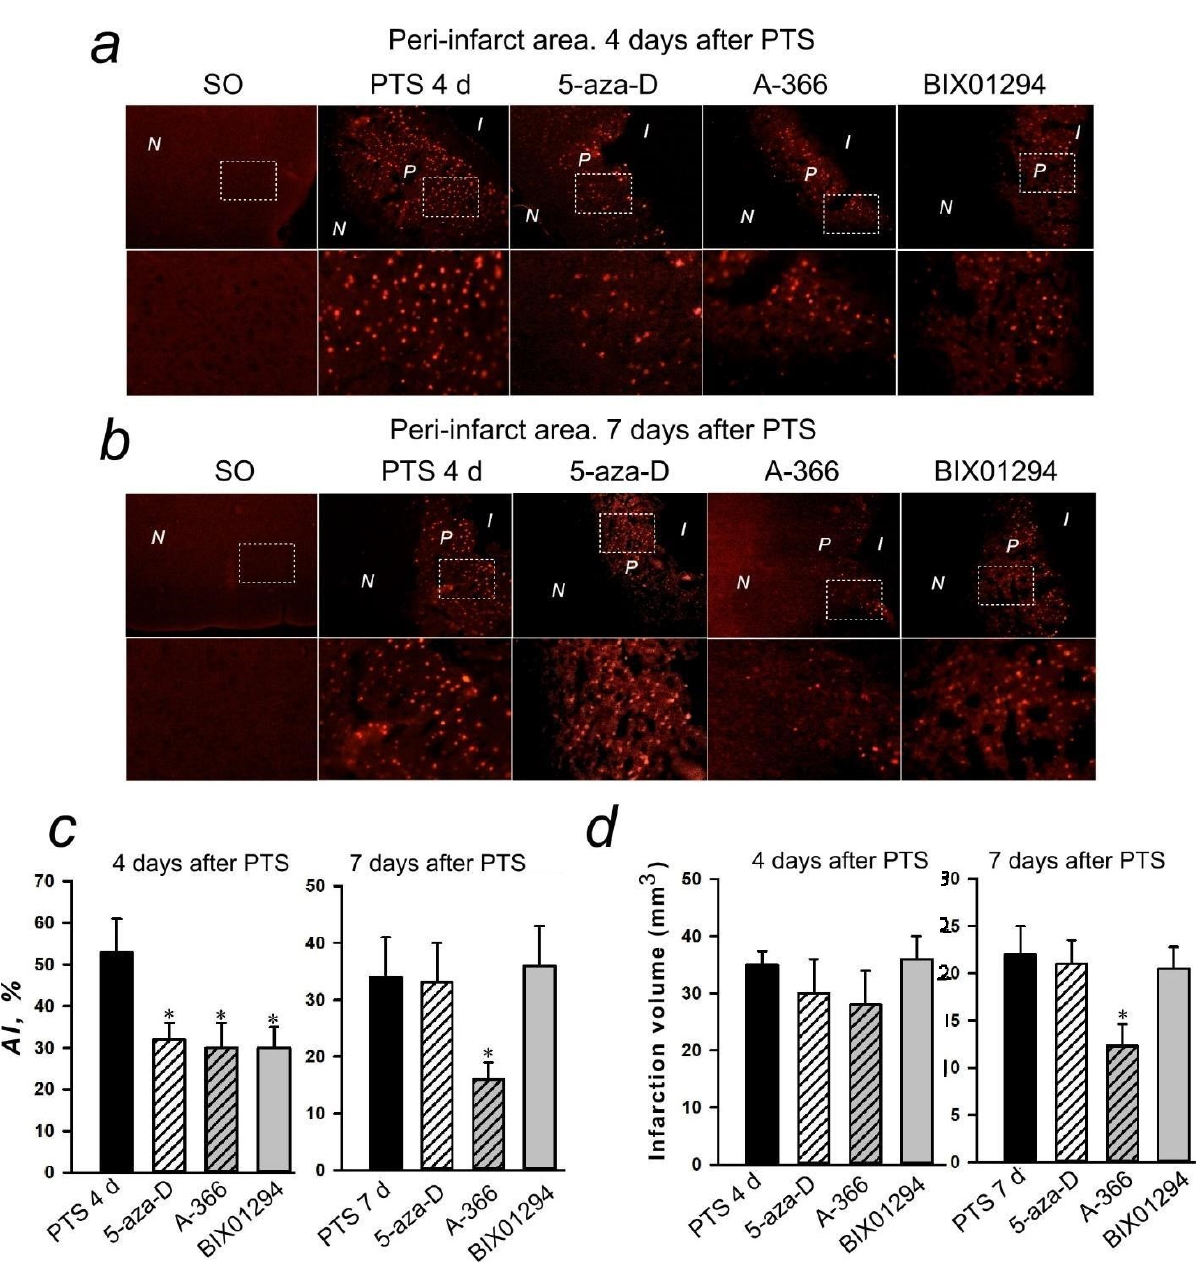
Figure 13. Apoptosis in the peri-infarct (P) area induced by photothrombotic stroke (PTS) in the mouse cerebral cortex. ( a , b ) Typical images of cortical regions stained with TUNEL (red fluorescence of apoptotic cells) at 4 days ( a ) and 7 days ( b ) after PTS. P-peri-infarct area, I-infarct area, N-normal tissue area. Control: sham-operated animals (SO). Experimental groups: The cerebral cortex of mice injected by various inhibitors. Inhibitors: 5-aza-2 ′ -deoxycytidine (5-aza-D), a selective DNMT1 inhibitor; A-366 and BIX01294, a nonspecific inhibitor of Suv39H1 and G9a. Scale bar 200 μ m, and the immunofluorescence of TUNEL in the peri-infarct (P) area at bigger magnification (Scale bar 50 μ m) ( c ) Changes in the apoptotic index (AI, %) in the mice of experimental groups at 4 and 7 days after PTS introduction of various inhibitors. ( d ) The effects of inhibitors of DNMT1 and methyltransferases Suv39H1 and G9a on the infarction core volume in the mouse brain at 4 and 7 days after PTS. Mean values of the infarction core volume (mm 3 ) in the control group (PTS without inhibitors) and in the experimental groups (administration of inhibitors). Scale bar 1 cm. One Way ANOVA; M ± SEM; n = 7–10. * p < 0.05 compared to the PTS in the absence of inhibitors.